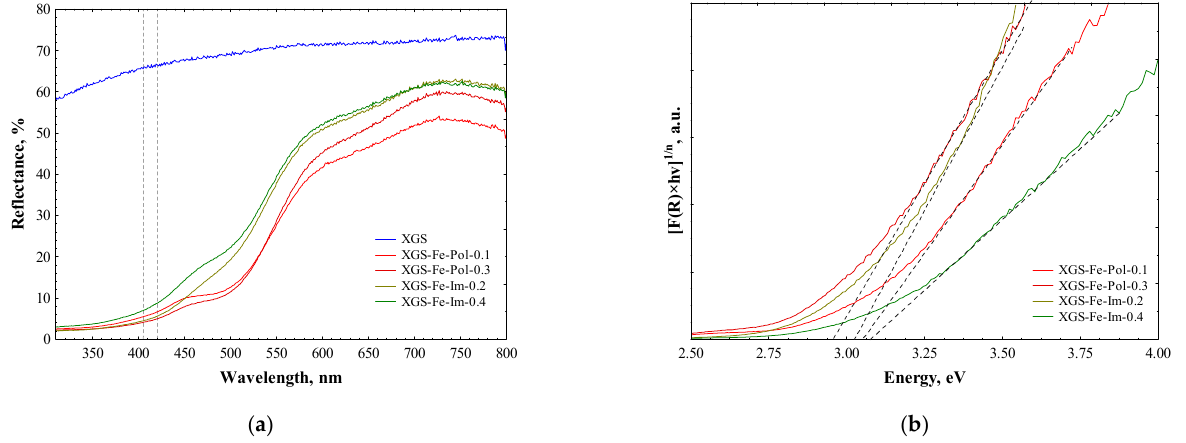
Figure 4. Photoelectronic characterization of the XGSs. ( a ) Diffuse reflectance spectra; and ( b ) Kubelka–Munk graphic for the determination of the band gap energy.